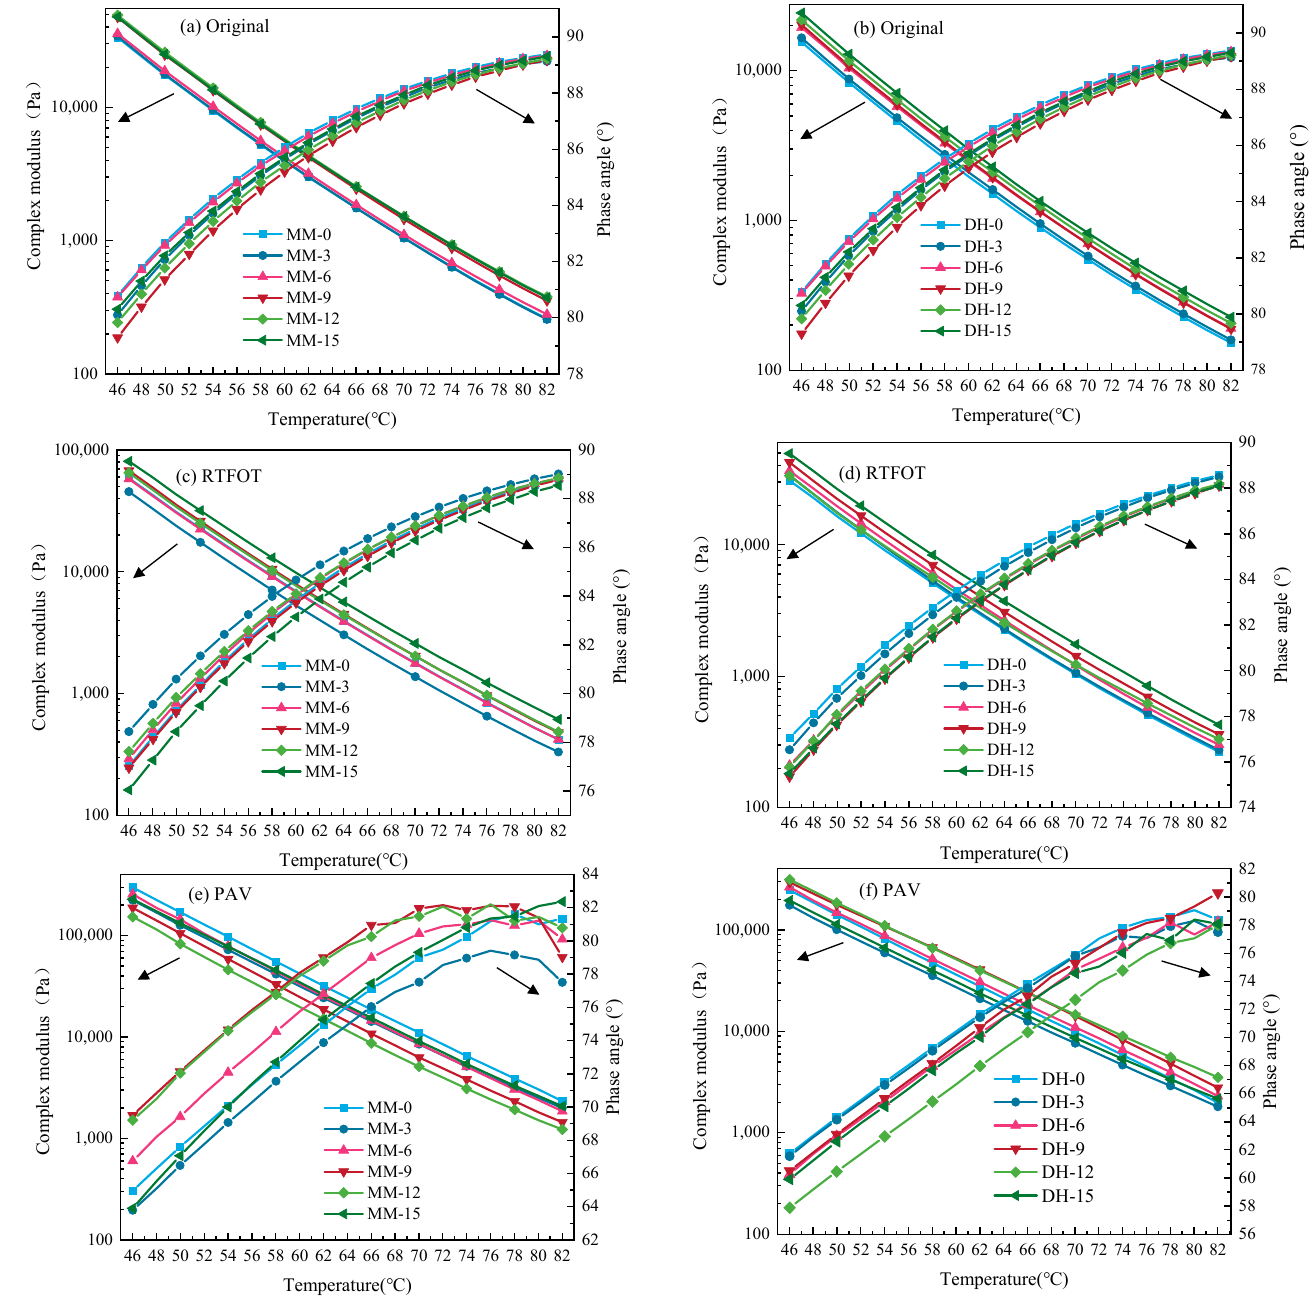
Figure 2. Results of complex shear modulus and phase angle of original and different aged asphalt with temperature. ( a , b ) represent the G * and δ of different asphalts before aging, ( c , d ) represent the G * and δ of different asphalts after short-term aging, ( e , f ) represent the G * and δ of different asphalts after long-term aging.